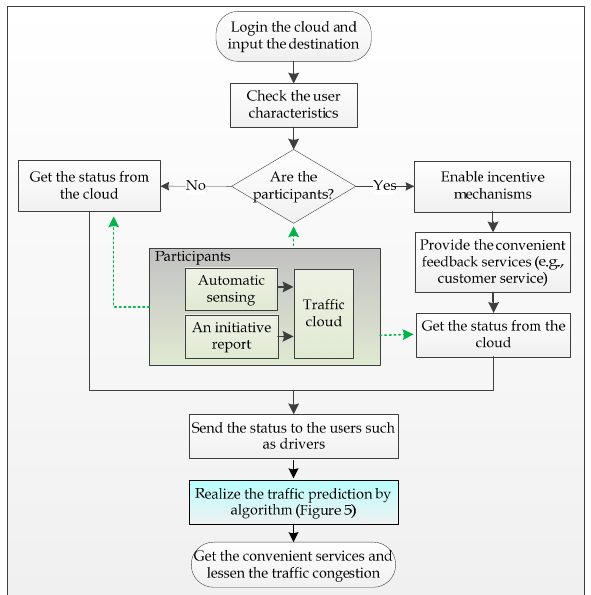
Figure 2. Flowchart of a cloud-assisted MCS traffic congestion control algorithm.